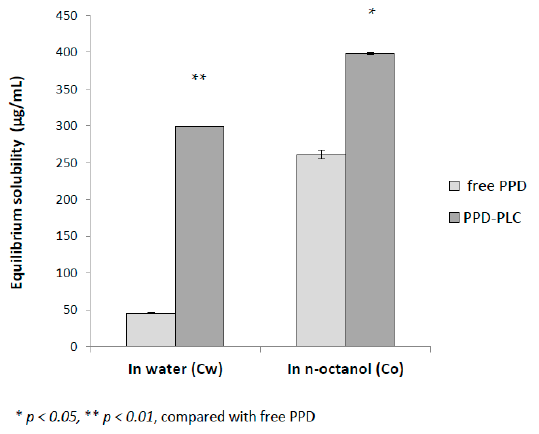
Figure 9. Equilibrium solubility of free PPD and PPD-PLC in water and in n -octanol at 25 °C ( n = 3, mean ± SD).